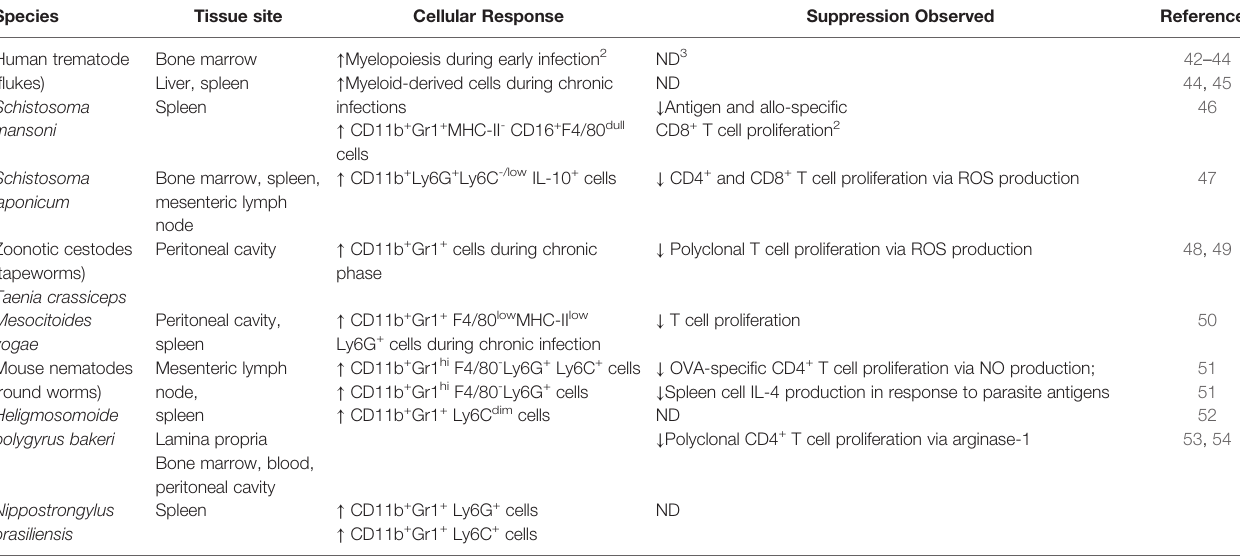
TABLE 1 | Human and zoonotic helminth species inducing differentiation and expansion of MDSC 1